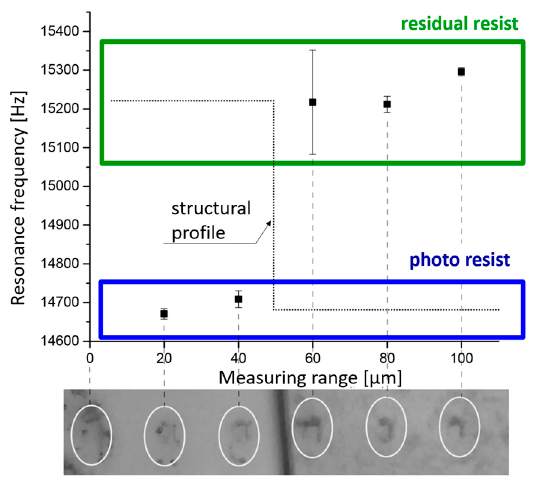
Figure 3. CRS measurement of a patterned PR-layer in the transition range of 100 µm between the layer and the uncovered substrate